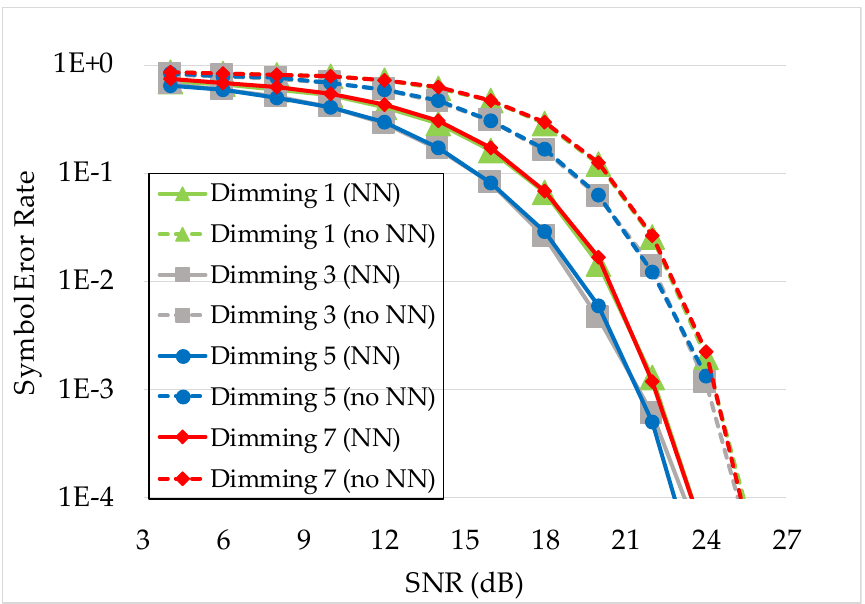
Figure 12. The comparison of symbol error rate (SER) performance between an NN-based decoder and a matched filter on different dimming cases with a blur kernel size of 40 × 40.